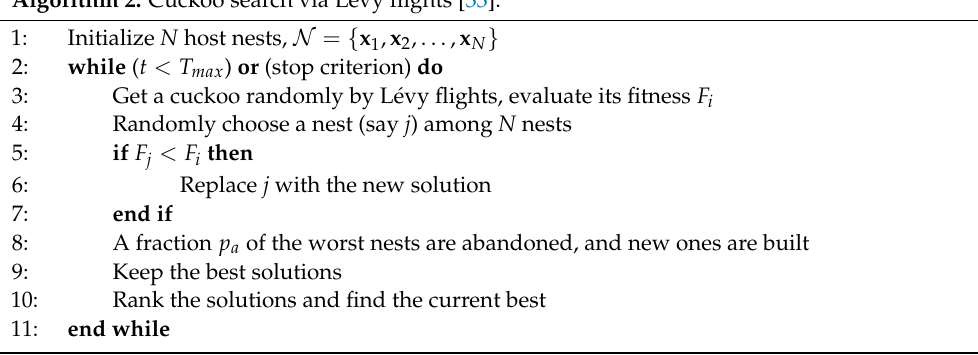
Algorithm 2. Cuckoo search via L é vy flights